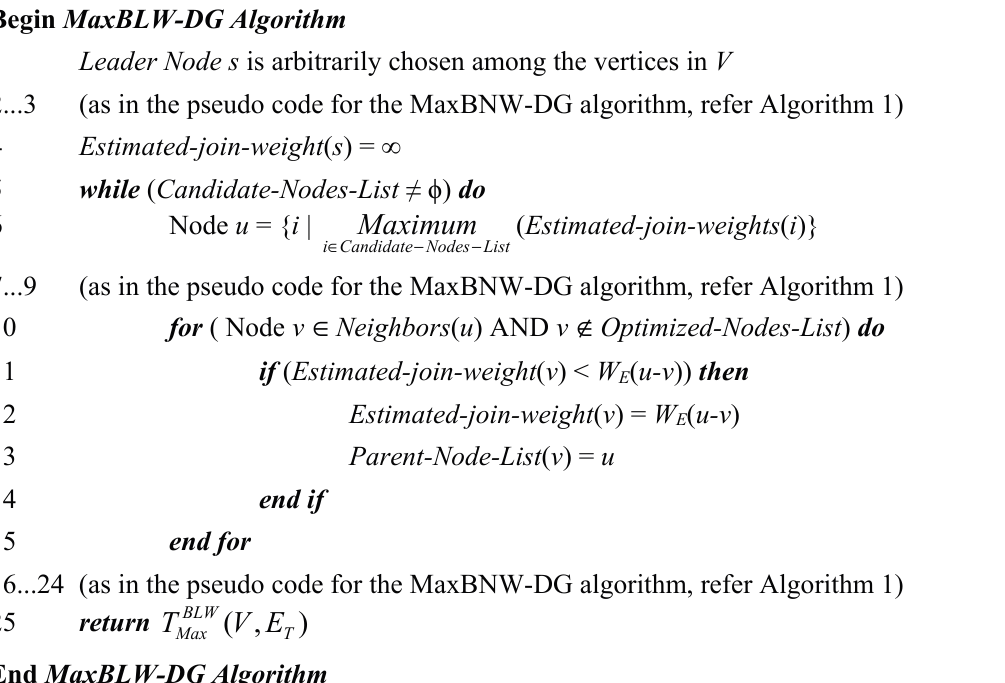
Algorithm 4. Pseudo Code for the Algorithm to Determine Minimum Bottleneck Link Weight-DG